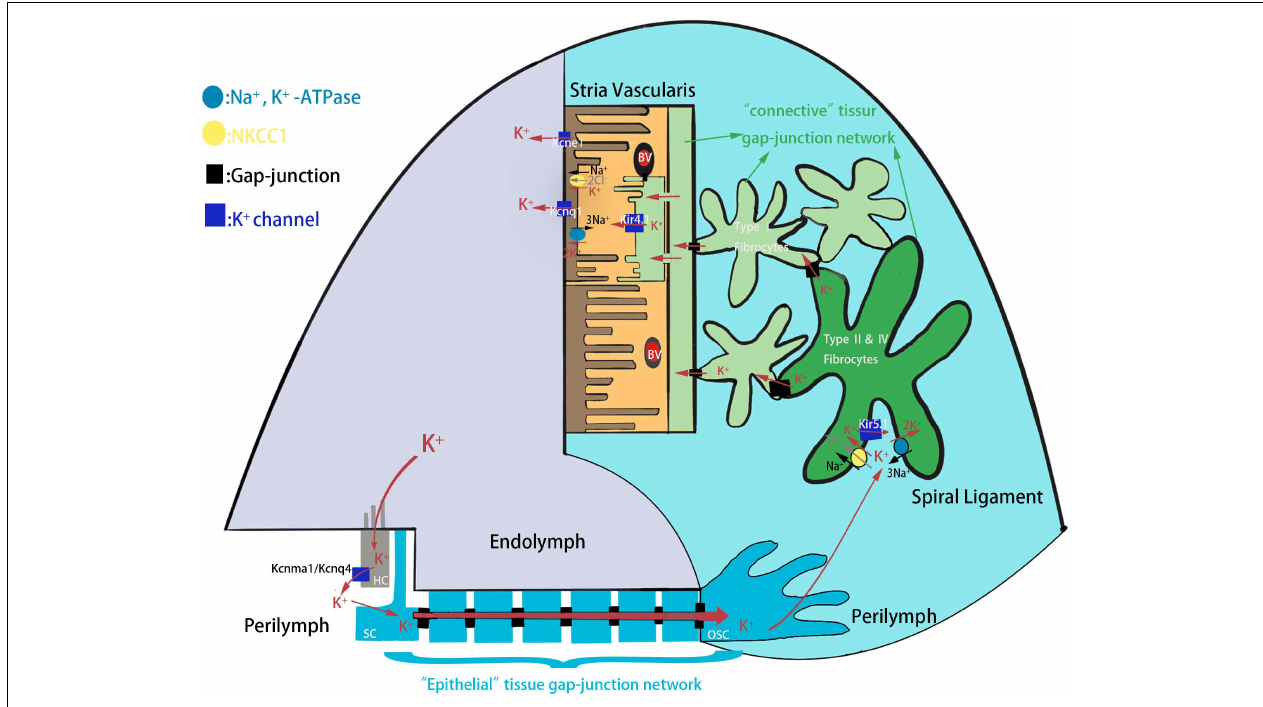
FIGURE 1 | The schematic model of K + circulation in mouse cochlea. K + exits from HCs into the perilymph and is reabsorbed by the SCs and is further transported to the spiral ligament of the cochlear lateral wall through epithelial tissue gap-junction network. K + is then reabsorbed by type II and IV fibrocytes, and recycled to the stria vascularis where it is finally secreted into the endolymph. HC, hair cell; SC, supporting cell; OSC, outer sulcus cell; BV, blood vessels.